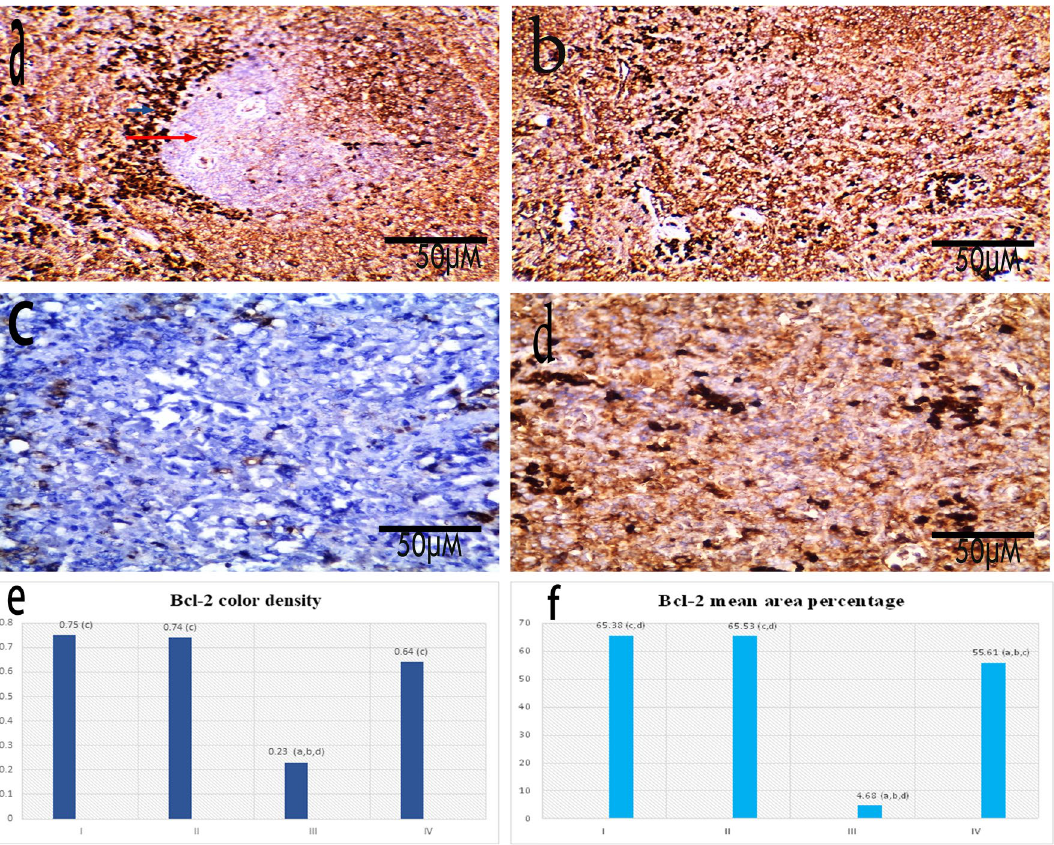
Figure 7. ( a ) Group I: Bcl-2 expression in spleen of a control rat showing positive expression of the red pulp as well as the mantle zone of the white pulp (blue arrow), while the germinal center of the white pulp showed negative bcl-2 expression (red arrow) [× 200]. ( b ) Group II: Bcl-2 expression in spleen of a control rat treated by FUC showing positive expression of the red pulp [× 200]. ( c ) Group III: Bcl-2 expression in spleen of a splenic dysfunction rat showing negative expression of the red pulp [× 400]. ( d ) Group IV: Bcl-2 expression in spleen of a splenic dysfunction treated by FUC rat showing positive expression of the red pulp [× 400], scale bar 50 μm. ( e , f ) Graphic representation of the morphometric results of Bcl-2 color density and the mean area percentage. Statistical analysis was carried out using one-way ANOVA with Tukey’s post hoc test, SPSS computer program. ( a – d ) Significant difference between groups at *p < 0.05. ( a ) Significance from group I; ( b ) significance from group II; ( c ) significance from group III; ( d ) significance from group